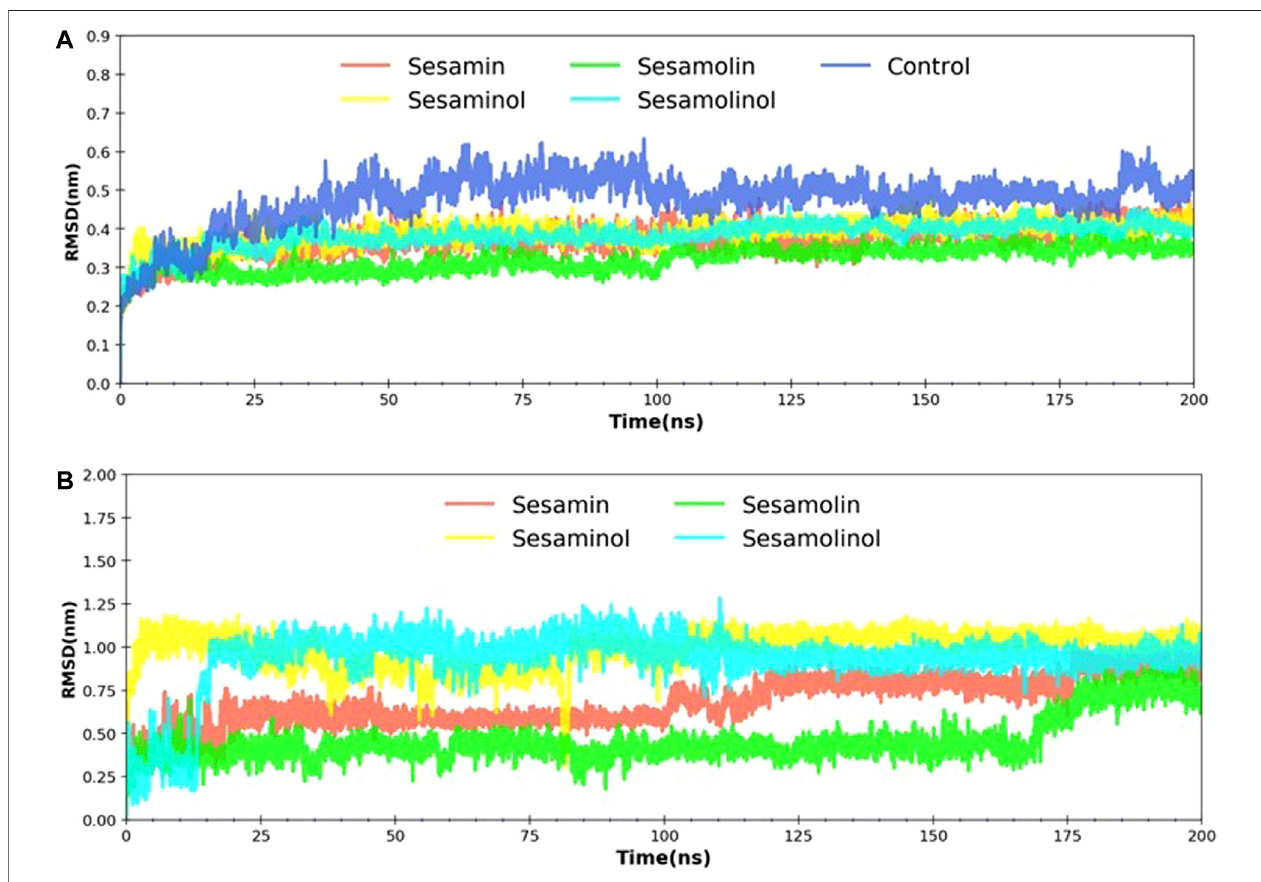
FIGURE 4 | RMSD analysis. (A) Backbone RMSD plot of docking complexes; and (B) ligand RMSD plot of complexes [M pro – sesamin complex (red), M pro – sesamolin complex (green), M pro – sesaminol complex (yellow), M pro – sesamolinol complex (cyan), and control (blue)].